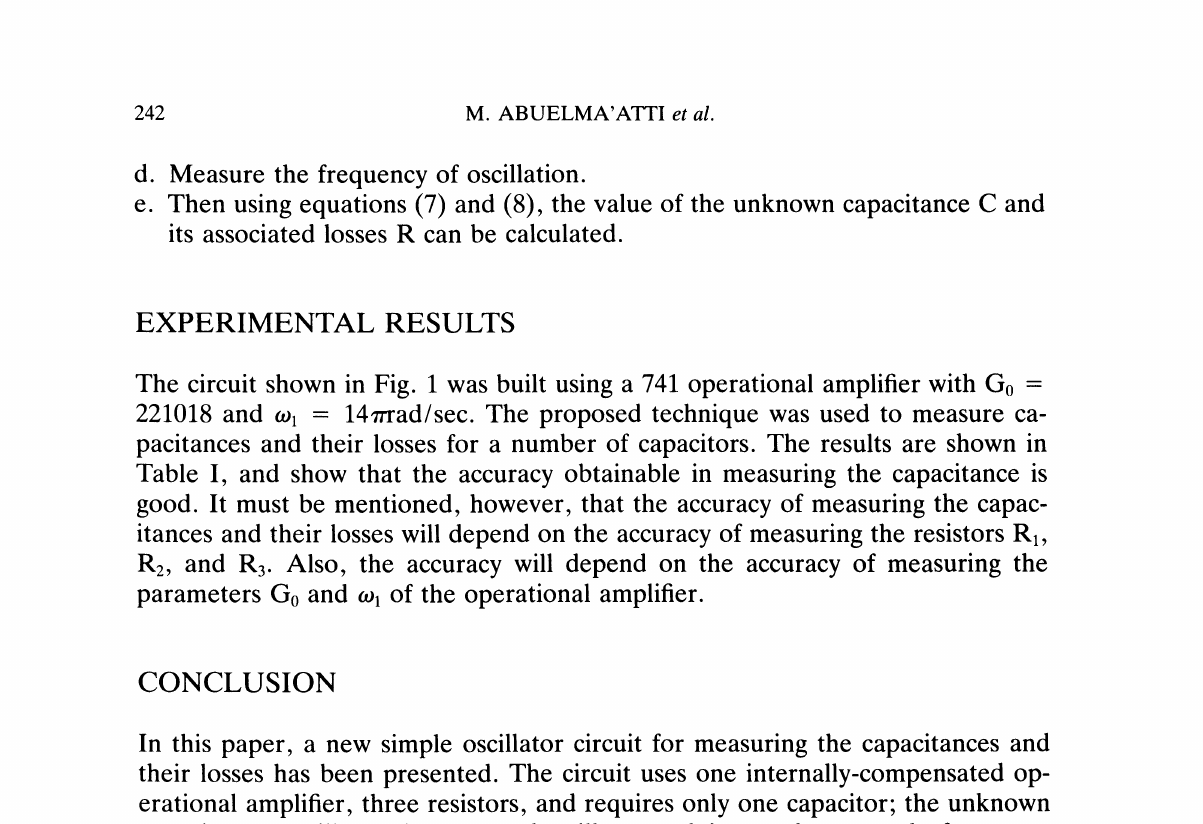
Measured and calculated capacitances.